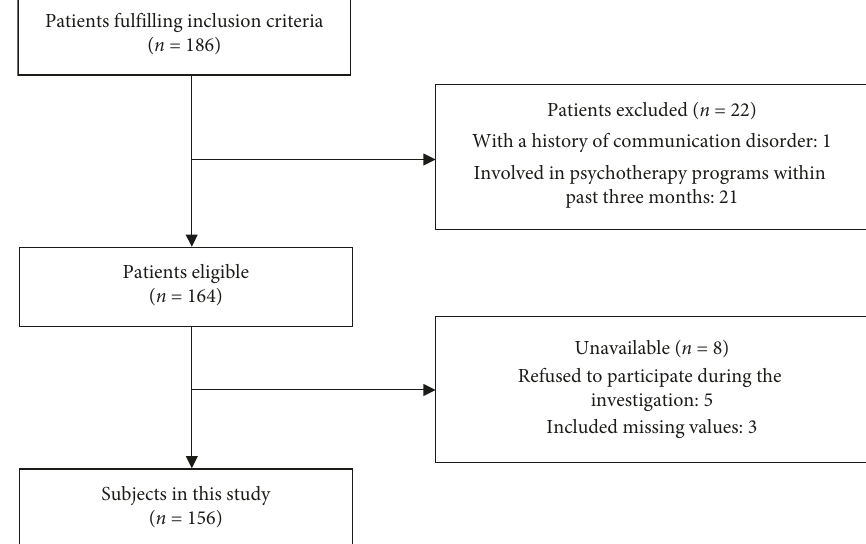
Figure 1: Flow chart outlining derivation of the